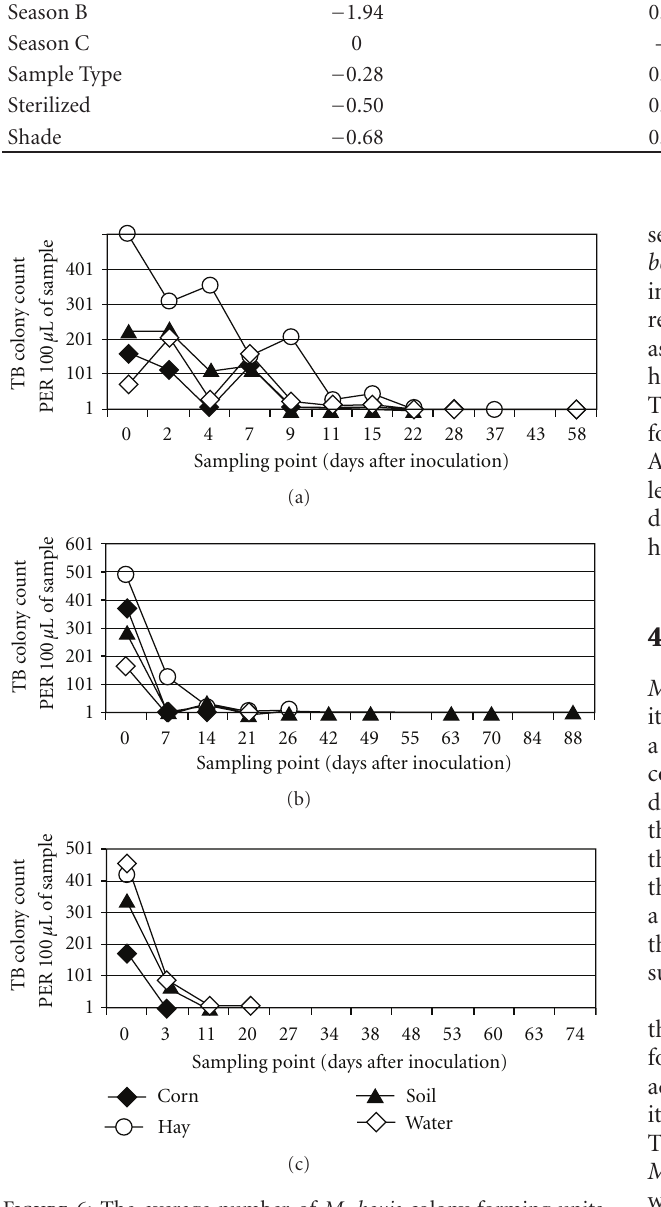
Figure 6: The average number of M. bovis colony forming units isolated on solid media from 100 μ L of processed sample (corn, hay, soil and water) over time in Fall/Winter (a), Winter/Spring (b), and Spring/Summer